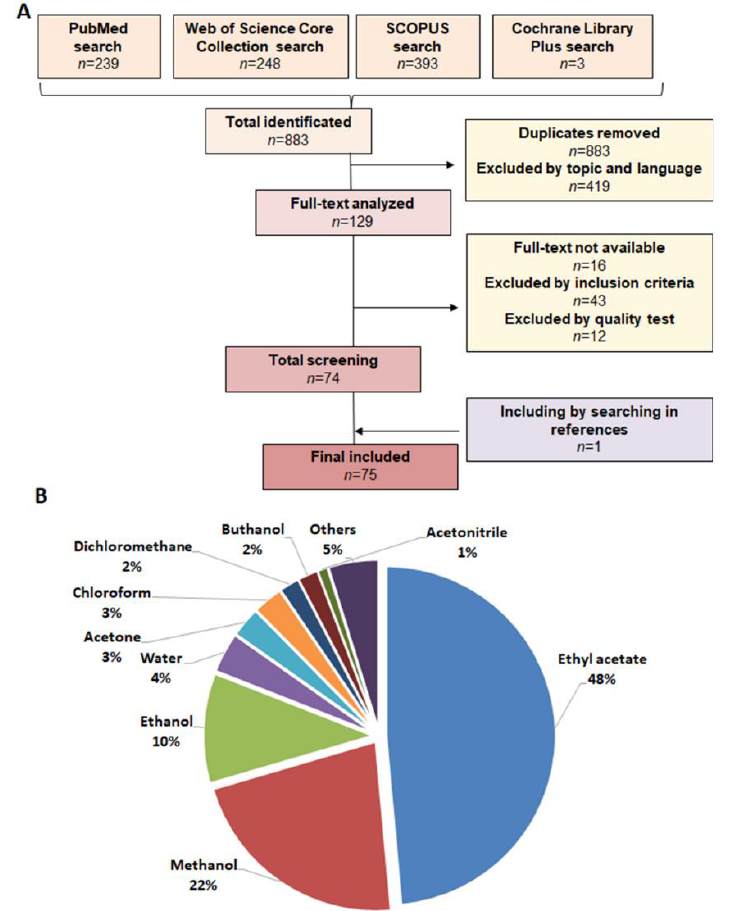
Figure 1. Flow diagram of the eligible studies included in this systematic review ( A ). Graphical representation of the method of extraction used to obtain the extract that was analyzed against tumor cells ( B ).